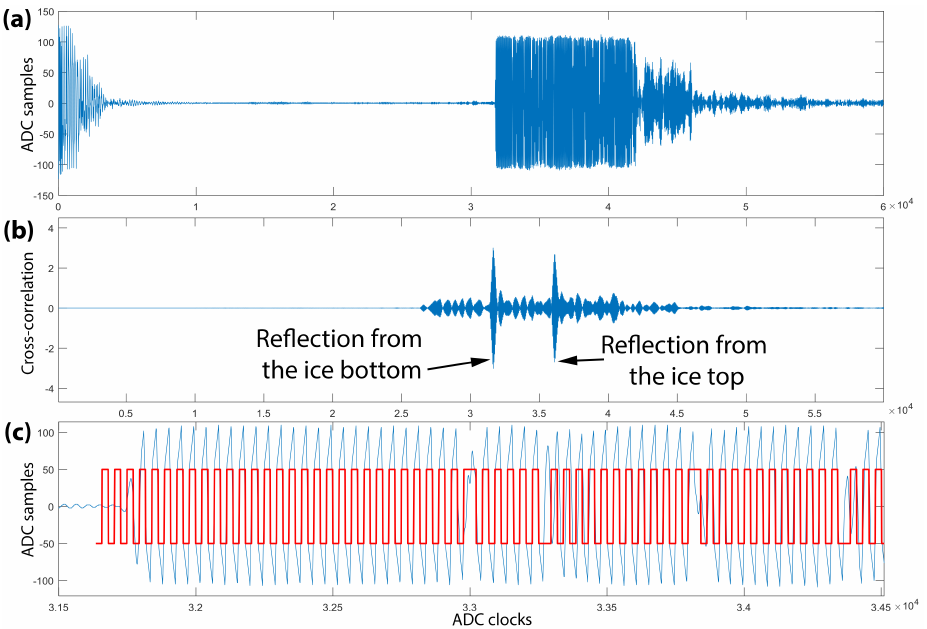
Figure 5. ( a ) Reflected signal waveform; ( b ) cross-correlation function of reflected signal with the reference signal; ( c ) zoomed in fragment of the reflected signal (blue line) with the superimposed reference signal (red